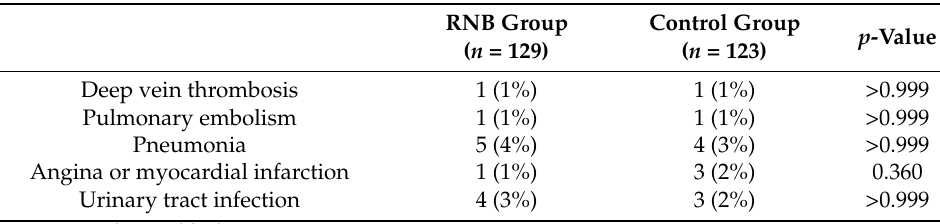
Table 7. Postoperative